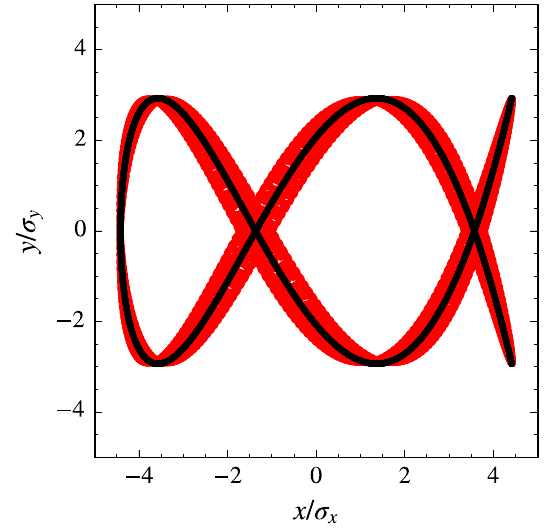
FIG. 4. Normalized projection of a C ¼ 20 fixed line excited by the seventh-order resonance 5 Q x þ 2 Q y ¼ m in the presence of space charge.